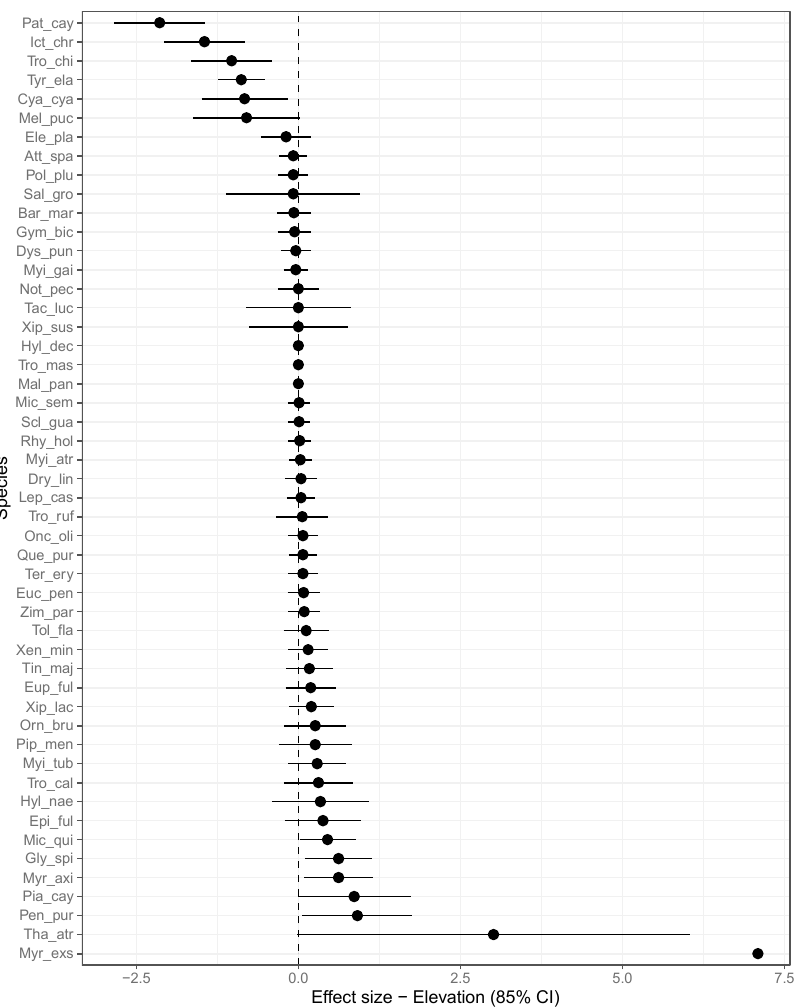
Figure 5. Model-averaged estimates of effect sizes of elevation on bird occupancy. Error bars are 85% confidence intervals.